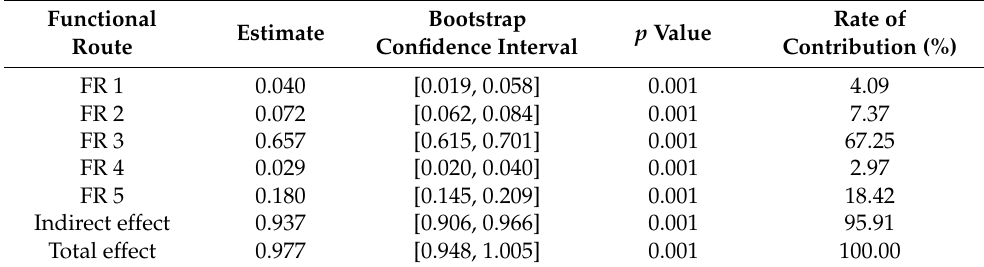
Table 13. Estimated results of functional routes of TII on EG. Functional